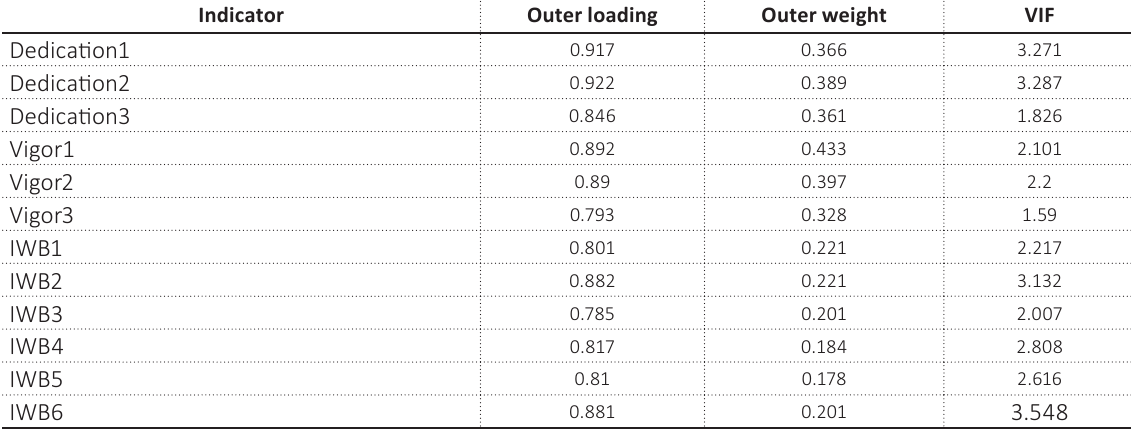
Table 4 (cont.). Outer loading, outer weight, and VIF for each indicator